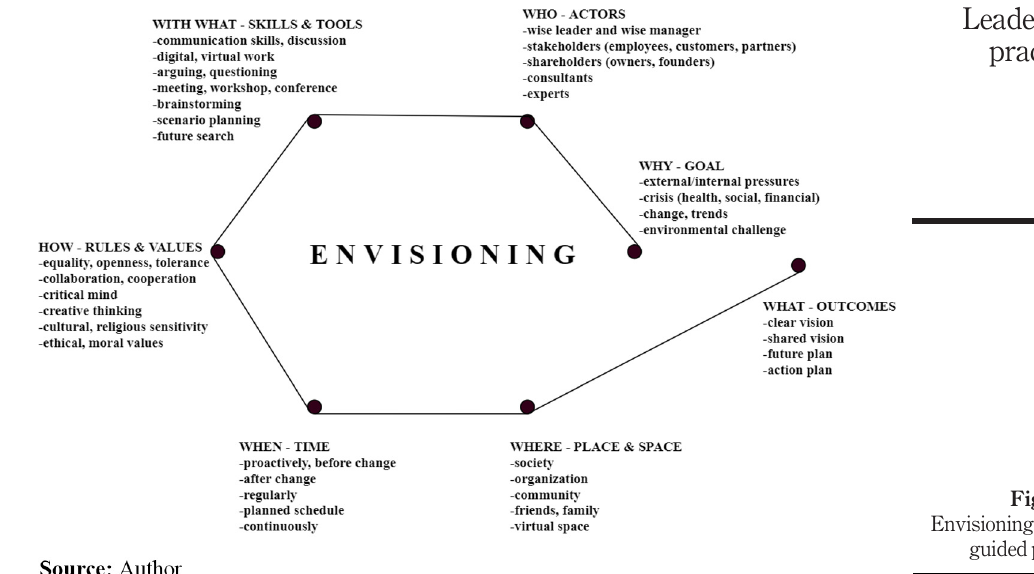
Figure 3. Envisioning as PW- guided